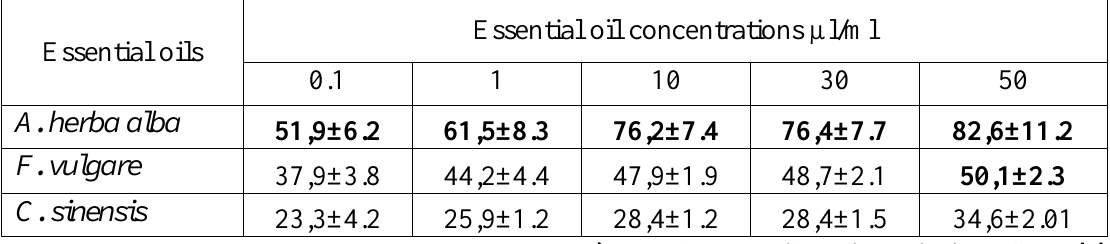
Table 5. Comparison of the Antifungal activity of A. herba alba, Foeniculum vulgare and Citrus sinensis essential oils against fungal strain.Values are the means of the inhibition rates ±